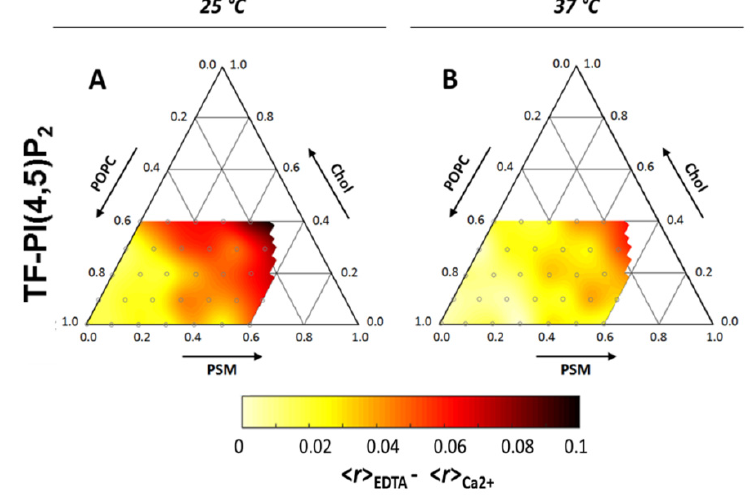
Figure 7. Ternary diagram for the POPC:PSM:Chol lipid mixture at 25 ◦ C ( A ) and 37 ◦ C ( B ). Color-code depicts decrease in measured fluorescence anisotropies of a PI(4,5)P 2 fluorescent analog (TF-PI(4,5)P 2 ) upon inclusion of 100 µ M Ca 2 + . Since the decrease reflects homo-FRET between analogs incorporated within the same clusters, darker areas correspond to more e ffi cient PI(4,5)P 2 clustering. Adapted with permission from Sarmento, M.J.; Coutinho, A.; Fedorov, A.; Prieto, M.; Fernandes, F. Membrane order is a key regulator of divalent cation-induced clustering of PI(3,5)P 2 and PI(4,5)P 2 . Langmuir 2017,